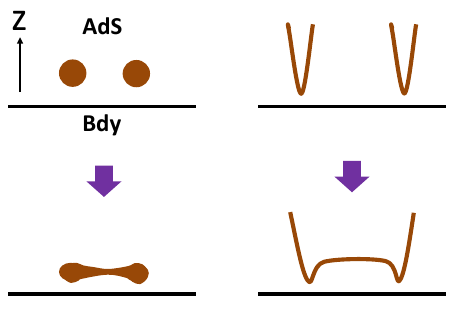
Figure 9 . Sketches of gravity duals of double local quenches. The upper left (or right) picture describes the gravity dual of a simple superposition of two single operator (or joining) local quenches, where no gravitational force between two heavy objects (brown colored ones) is taken into account. The lower left (or right) depicts a gravity dual of double operator (or joining) local quench where the back reactions are incorporated. In the left, a local operator is dual to a massive particle. In the right, the heavy string is dual to the boundary surface in the joining local quench. In both examples, gravitational forces bring the two objects closer and their back-reaction appears weaker to a distant